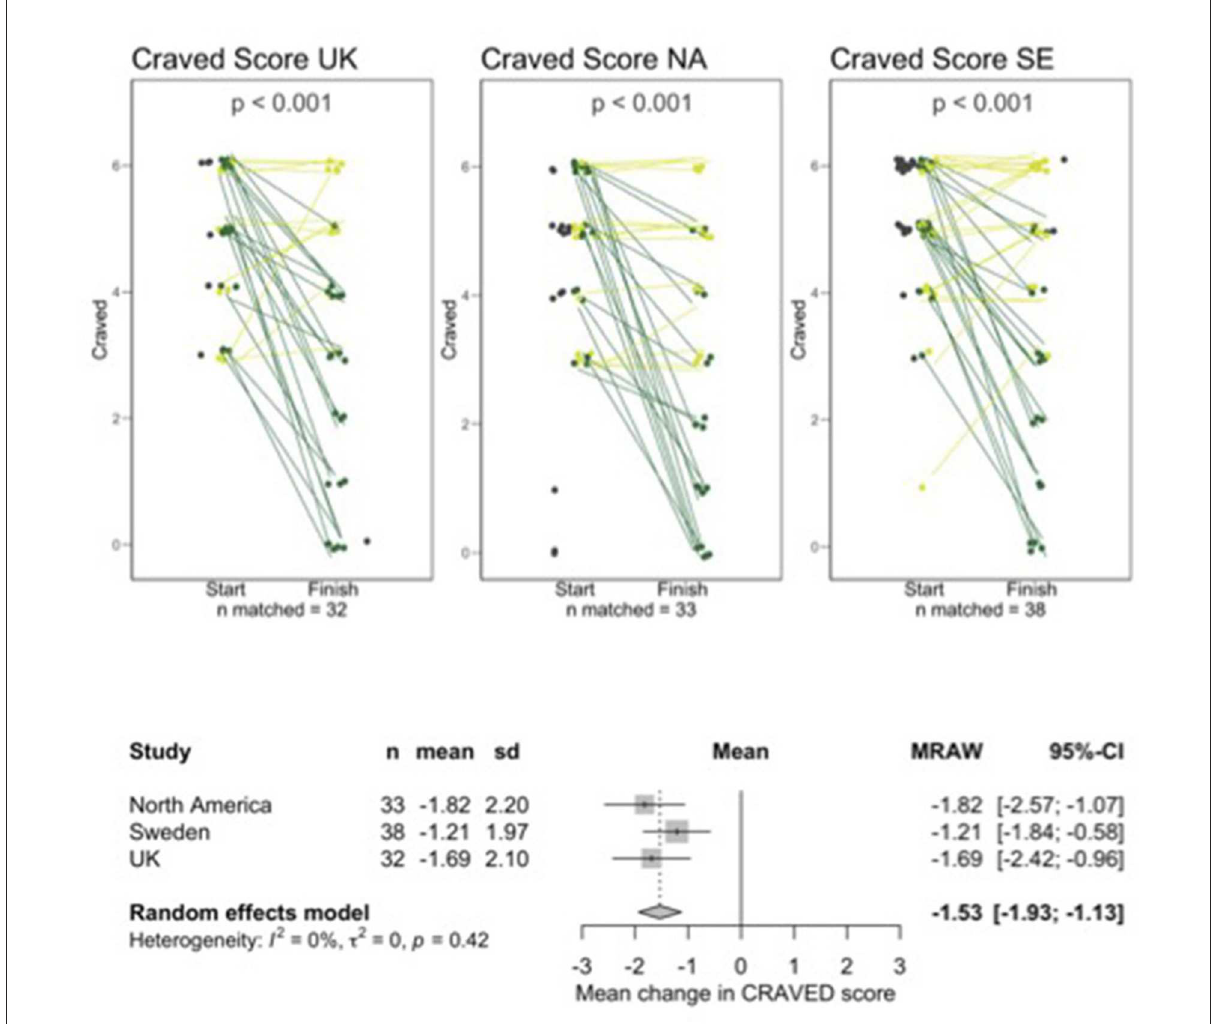
FIGURE2 Line and forest plots for CRAVED. Dark green indicates improved scores, light green indicates worsening score or no change. Dark gray data points without a line represent people who started but did not finish or who completed a follow up questionnaire but could not be matched with a starting